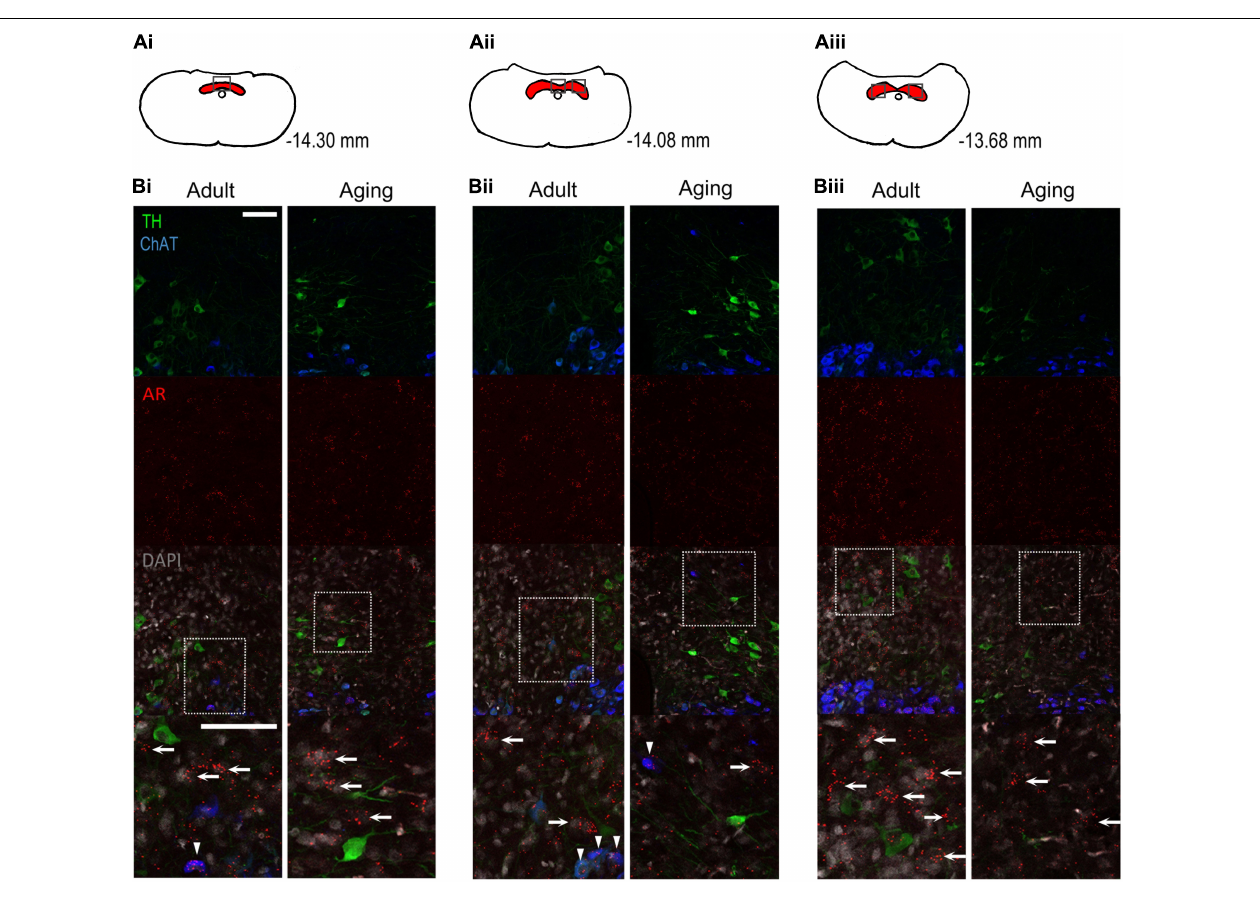
FIGURE 2 | Androgen receptor mRNA is found in cells comprising the caudal NTS. (AI–III) Coronal sections from the rat caudal medulla showing the caudal NTS (red) and imaging locations (black boxes). Coordinates = mm from bregma. Adapted with permission from Paxinos and Watson (1998). (BI–III) Representative confocal images of the NTS at 25 × in adult and aging male rats. ChAT-positive neurons comprise the dorsal vagal complex (arrowheads = co-localized with AR), while TH-positive neurons comprise the A2-region. Bottom panel = region of interest in merged image. AR mRNA is present in Chat/TH-negative cells (arrows) within the boundary of the NTS. N = 7 rats. Scale bars = 75 µ